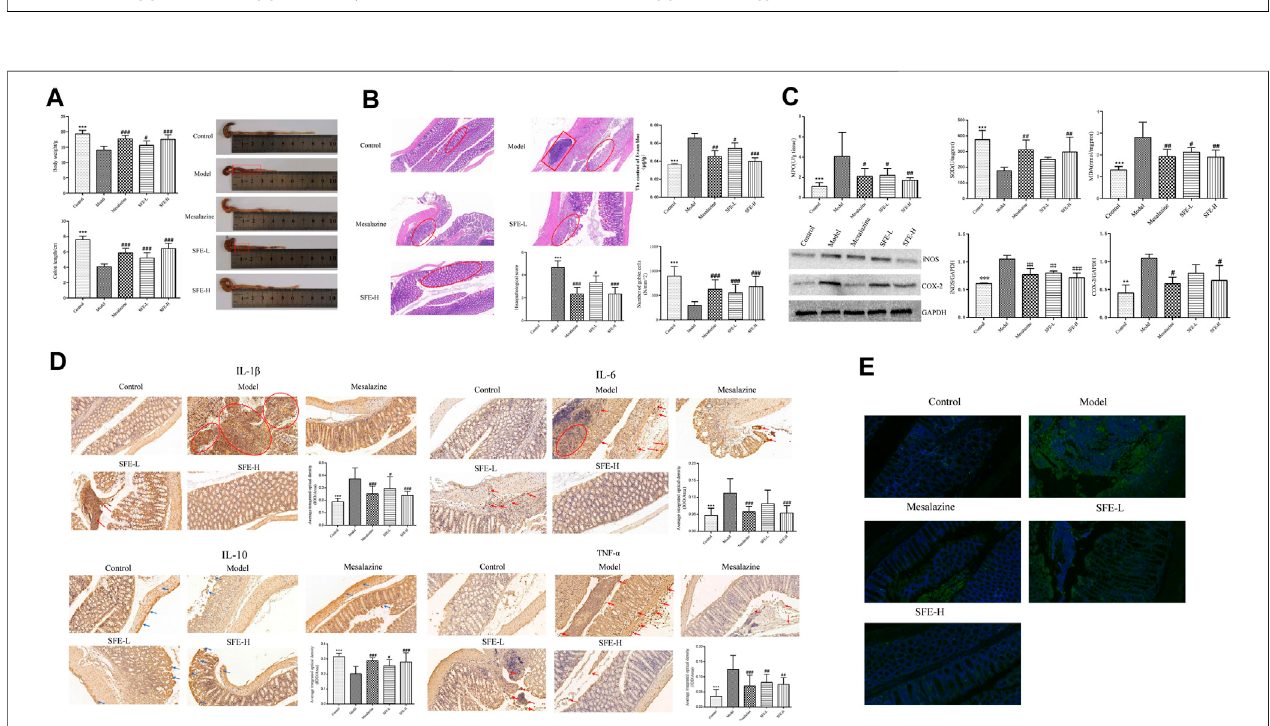
FIGURE 2 | SFE treatment alleviated DSS-induced UC. (A) The body weight and colon length of mice. (B) The pathological slice of mice ( × 400 magni fi cation), pathologicalscore,thenumber ofgoblet cells,and thecontentofEvansblue ofmice. (C) Theactivity ofMPO andSOD, thecontentofMDA, and theexpression ofiNOS and COX-2 in the colon tissue of the mice. (D) The immunohistochemical slice of the mice that express the secretion of IL-1 β , IL-6, IL-10, and TNF- α , and their average integrated optical density of the cells. (E) The investigation of CD4 + T cells in the colon tissue of mice by immuno fl uorescence. * means that the control group comparedwiththemodelgroupissigni fi cant;#meansthatthemodelgroupcompared withtheadministrated groupissigni fi cant;*,#means p < 0.05;**,##means p < 0.01; ***, ### means p < 0.001.